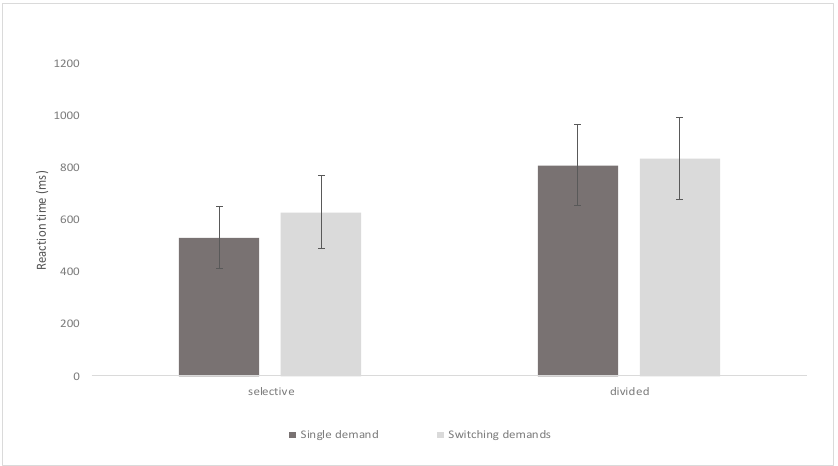
Figure 2. Usage behavior for single applications in gaming and smartphone use for the total sample and divided by gender.